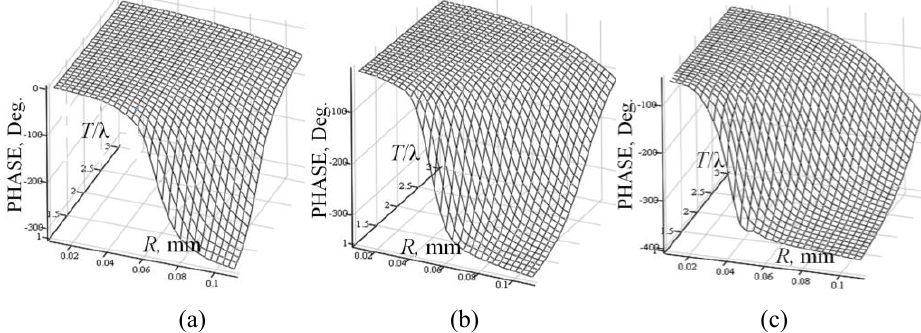
Fig. 2. Reflection-coefficient phase dependence on R and T /λ for crossed dumbbell slots at: (a) 19 GHz; (b) 21 GHz; (c) 23